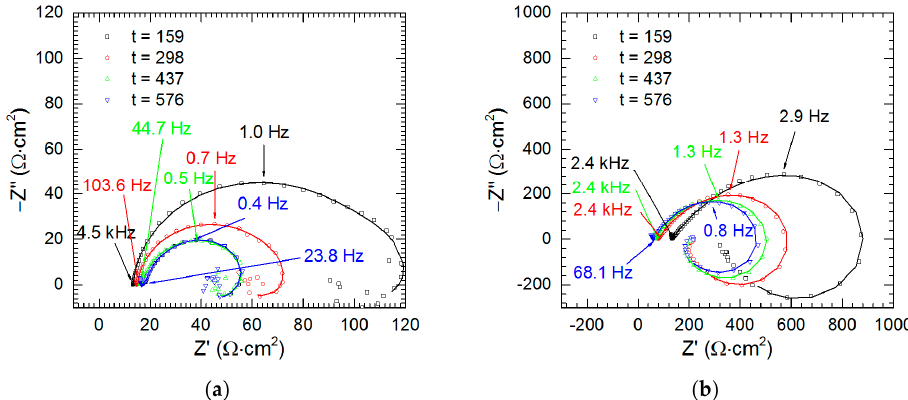
Figure 14. Kinetics of selective corrosion of intermetallic Al 2 Cu: ( a ) double-layer capacitance at pH = 1.3; ( b ) charge-transfer resistance at pH = 1.3 and= 2.5; c V = 0 mM, T = 303 K. Figure 13. Impedance spectra of intermetallic Al 2 Cu as a function of immersion time: ( a ) pH = 1.3; ( b ) pH = 2.5; T = 303 K, c V = 0 mM. Table 5. The results of fitting of the impedance spectra obtained at pH = 2.5 using EEC from Figure 11a: χ 2 and S indicate the quality of the fit (chi-square and residual sum of squares, respectively); R s is